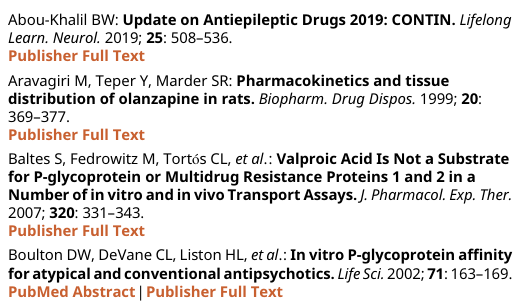
Figshare: Extended data for ‘ Entry of the antipsychotic drug, olanzapine, into the developing rat brain in mono- and combination therapies ’ . https://doi.org/10.26188/c.6273693 (Huang et al. , 2022)